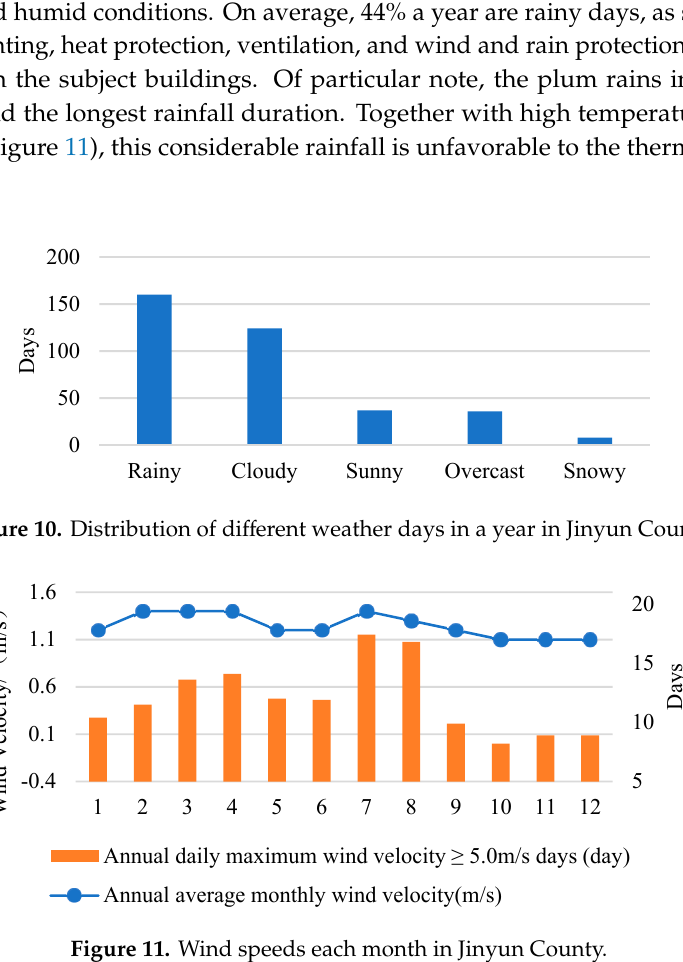
Table 2. Average meteorological parameters for Jinyun County in June (1990–2010).